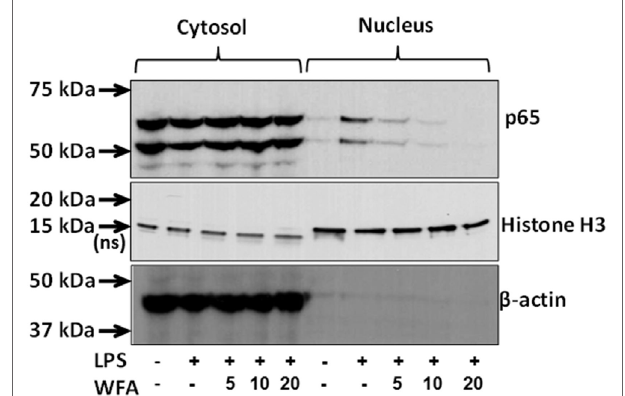
FigUre 3 | Inhibition of nuclear factor-kappa B (NF- κ B) activation by withaferin A (WFA). Cell lysates from the cytoplasmic and nuclear fractions of lipopolysaccharide (LPS)-stimulated THP-1 cells following WFA (5, 10, 20 µM) treatment were subjected to protein expression analysis with antibodies for NF- κ B, β -actin, and Histone H3 (a nuclear marker). NF- κ B signaling molecules at the expected molecular weights of 50 and 65 kDa were observed both in both the cytosolic and nuclear fractions. The estimated size of 18 kDa for Histone H3 protein in nuclear lysate serves as internal control, whereas a non-specific band at ~15 kDa in the cytoplasmic fraction was also observed. Beta-actin (43 kDa) serves as an internal control for the cytoplasmic lysates. The experiment was performed twice with similar observations from two independent cell